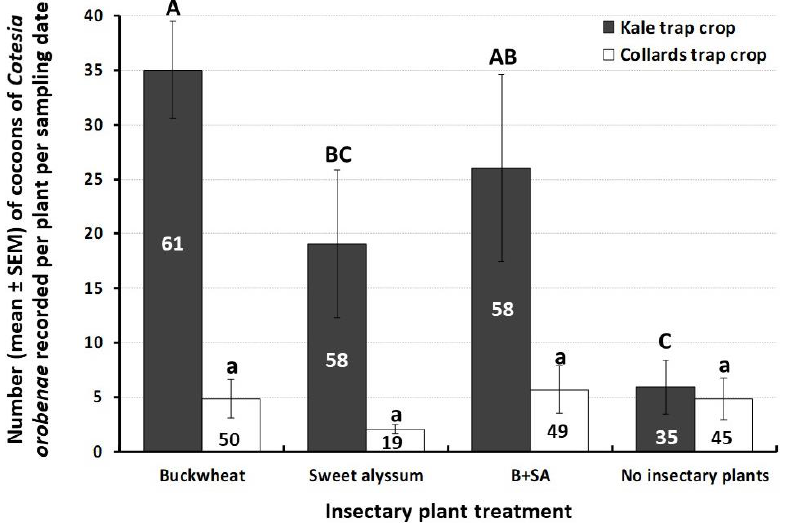
Figure 3. Trap crop parasitism of the herbivore Evergestis rimosalis by the braconid wasp Cotesia orobenae . B + SA = Buckwheat and sweet alyssum mixture. Numbers inside bars indicate average percent parasitism. For each trap crop species, bars with di ff erent letters are significantly di ff erent according to ANOVAS and Fisher-protected LSD tests ( p <